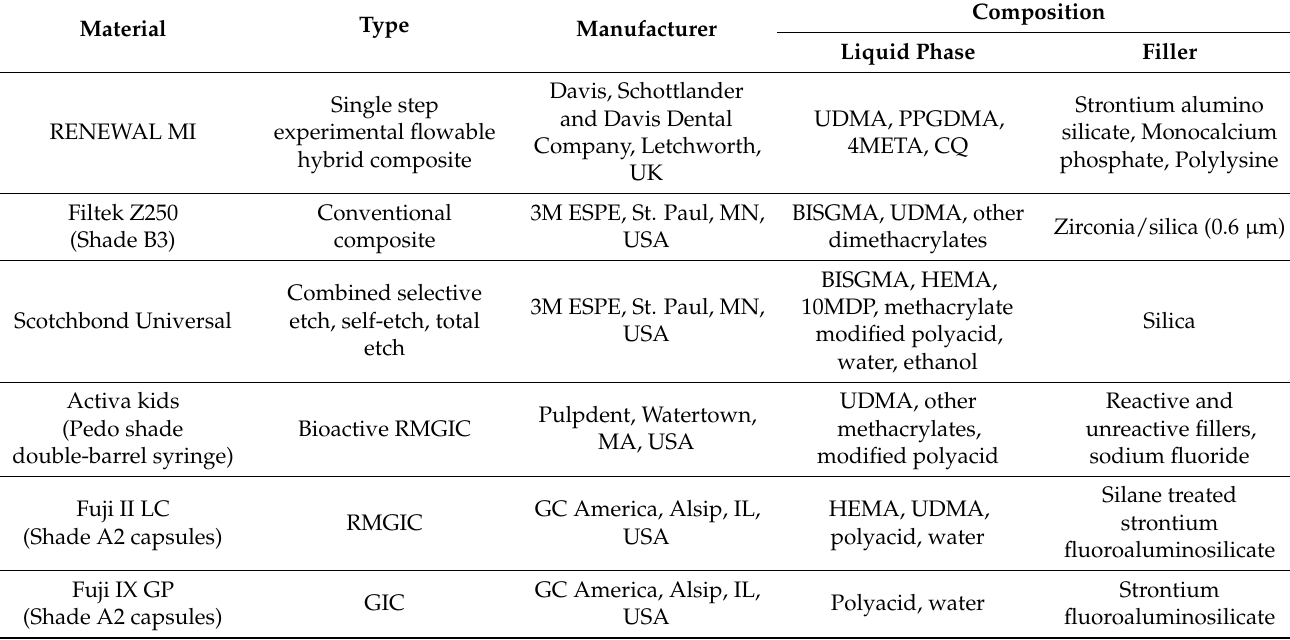
Table 1. Main components in materials under investigation according to